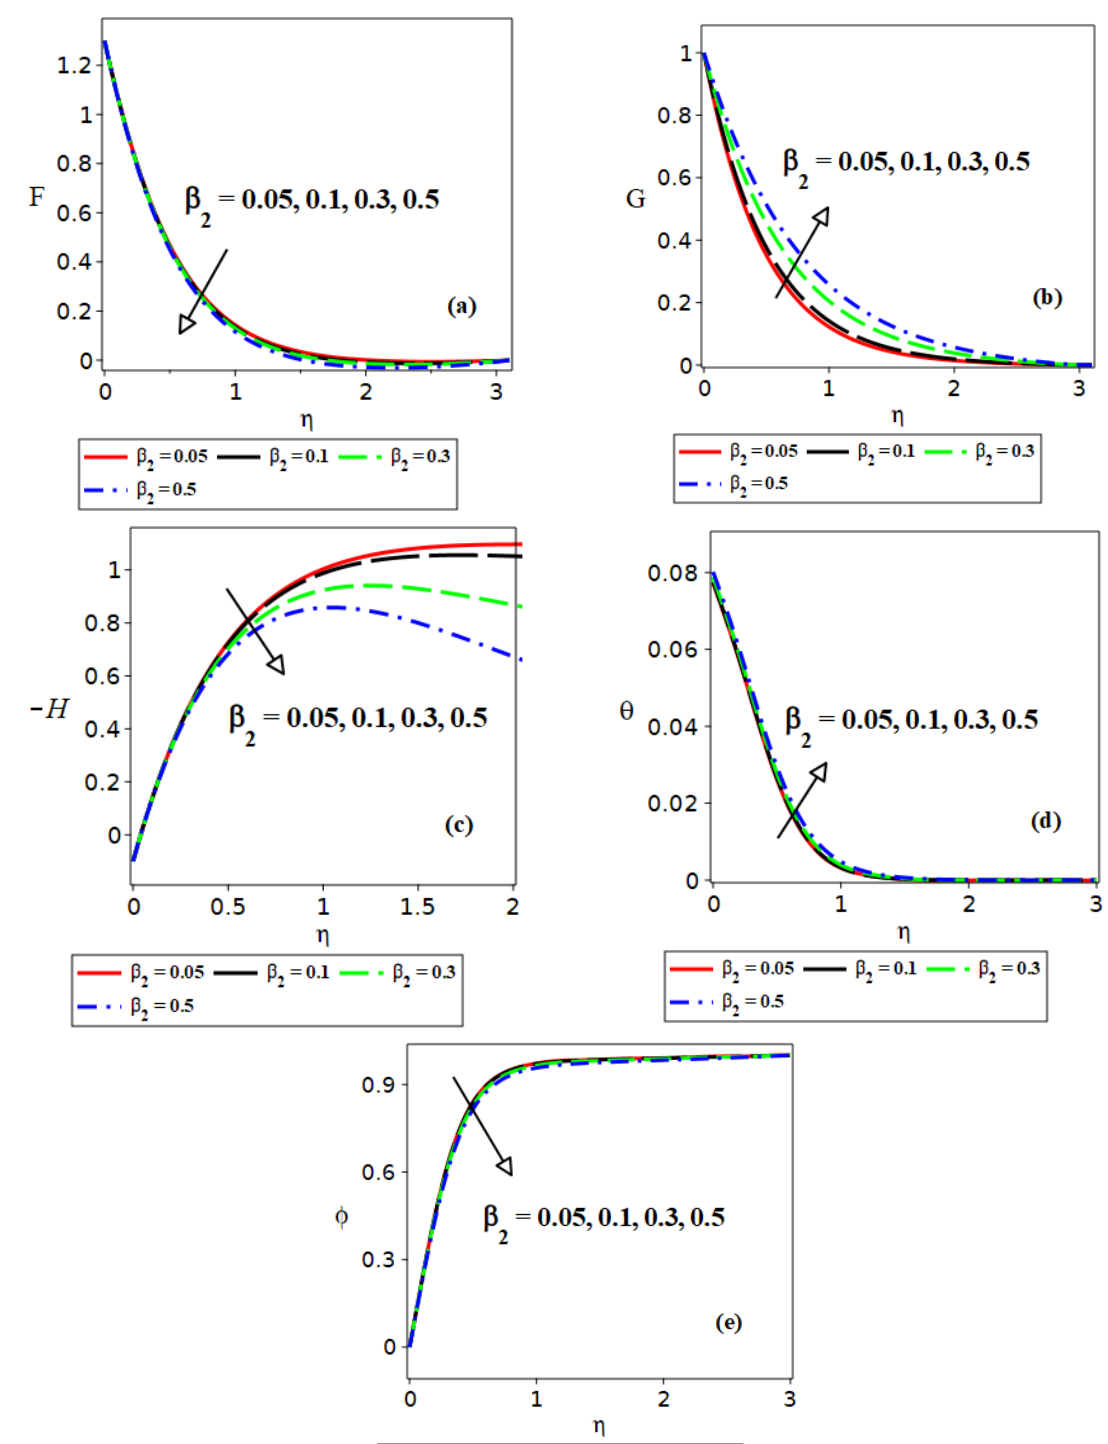
Figure 3. Effect of 𝛽 (cid:2870) on (𝐚) 𝐹, (𝐛) 𝐺, (𝐜) (cid:4668)−𝐻(cid:4669), (𝐝) 𝜃, and ( e ) 𝜙 . Figure 2a–e highlight the effect of stretching parameter R on the flow, thermal, and solutal fields. The sketches make it clear that the velocity field is radially increasing and azimuthally decreasing. Because R is the stretch to swirl rate ratio, when the rate of